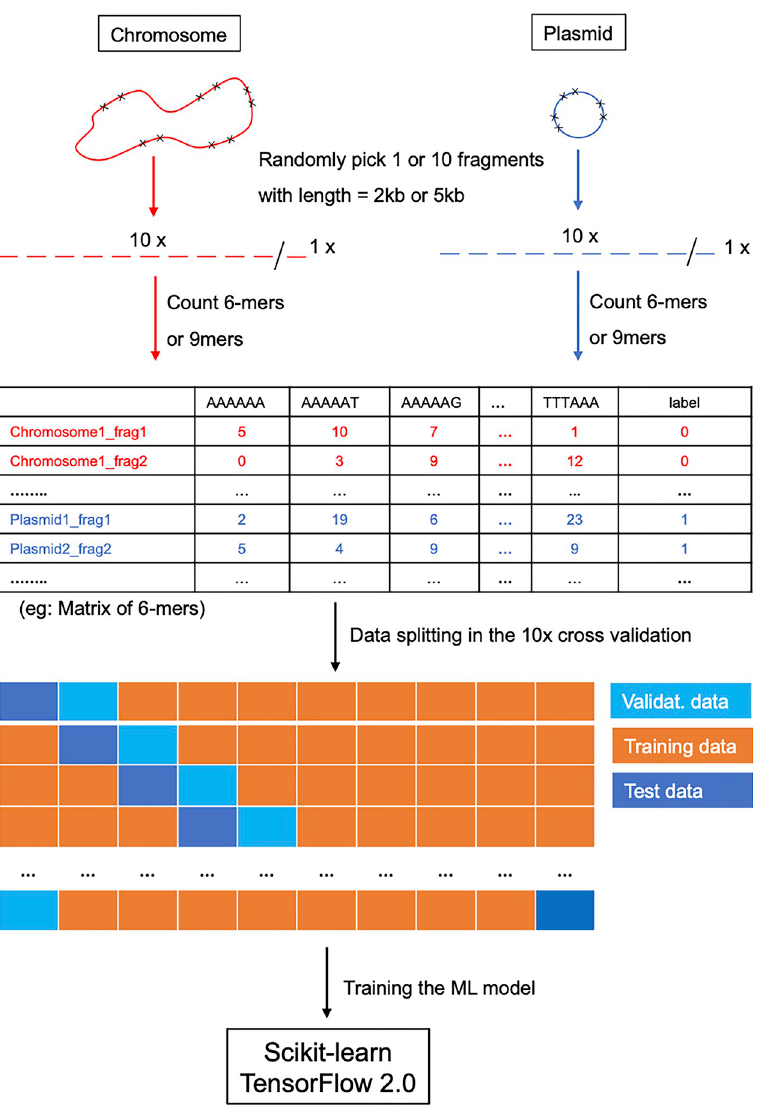
Fig 2. Workflow for the